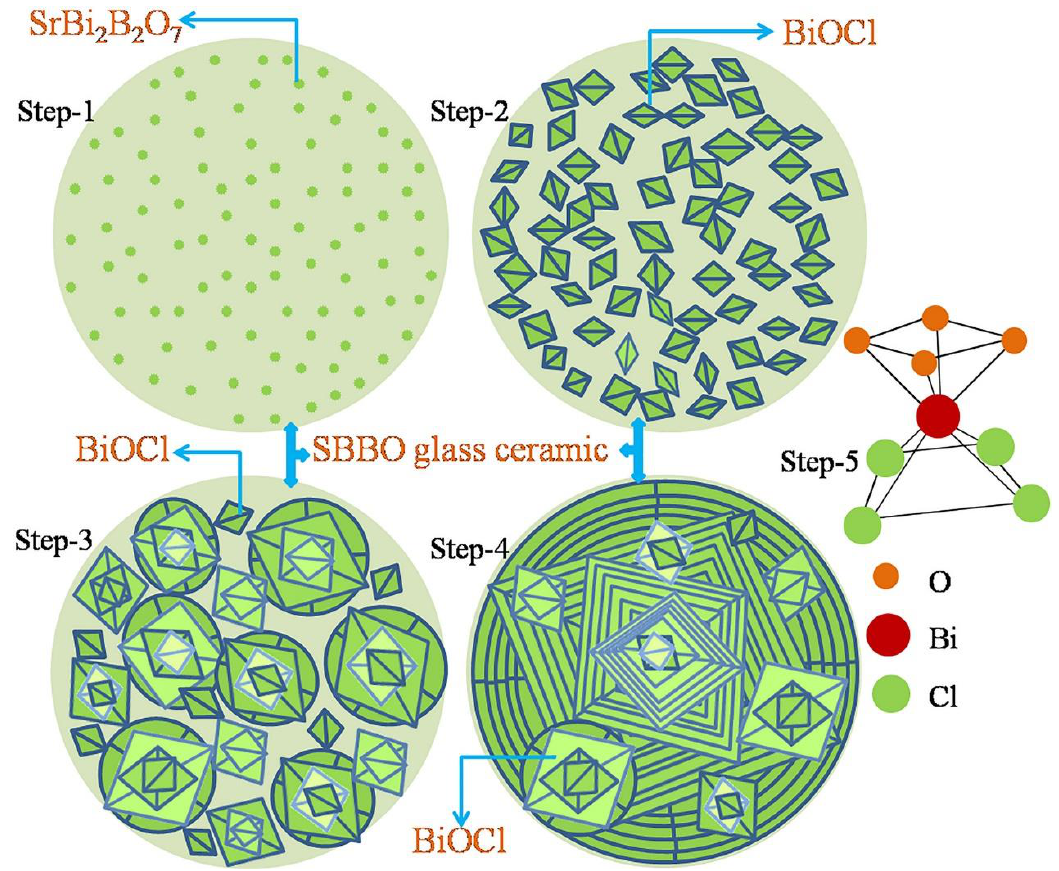
Figure 14. Schematic diagram of the mechanism for the photocatalytic degradation of pollutants under UV light irradiation. Reprinted with permission from Ref. [113].